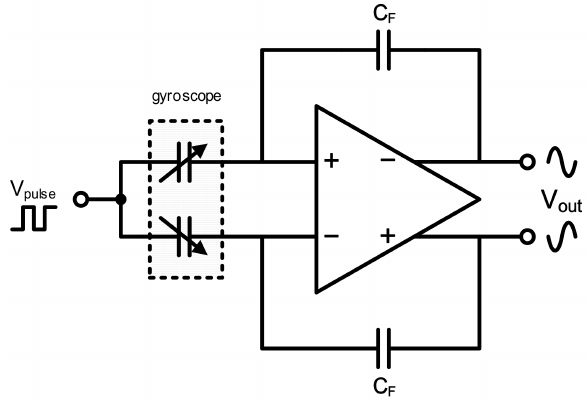
Figure 1. C/V conversion stage in gyroscope interface Application Specific Integrated Circuits